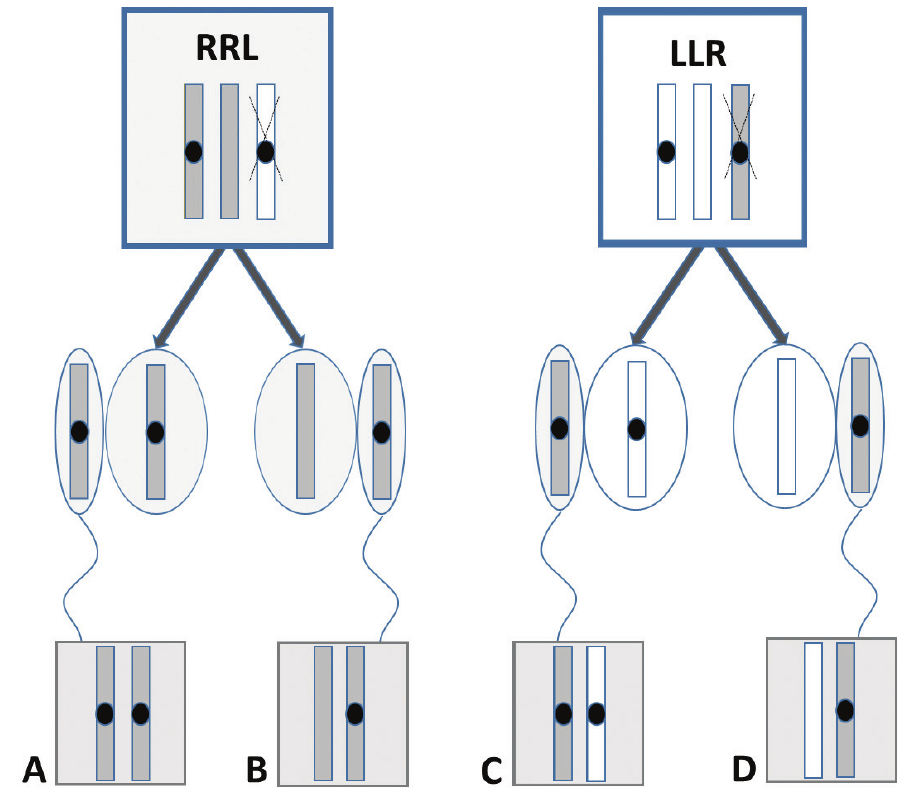
Figure 3. Inheritance of NORs by progeny of triploid females RRL (right) and RLL (left). The chromo- some set represented by one copy is eliminated before oogenesis (marked by X) and the double one is segregated into eggs (represented by ovals). After fertilization (in this case by ridibundus sperm), two types of progeny arises: with two ( A and C ) and with one ( B and D ) NOR. The lack of NORs are transmitted ei- ther by lessonae (white) or by ridibundus (dark grey) chromosome sets. NORs are represented by black dots.